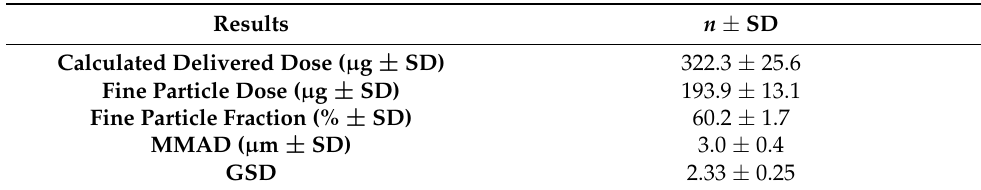
Figure 6. Summarized data showing ACI different stages deposition of nebulized FPV-SLN for- mulations ( n = 3, mean ± SD). Table 3. Aerodynamic characterization of nebulized aerosol from the jet nebulizer with 400 µg delivered dose of FPV-SLN formulations ( n = 3, mean ± SD).